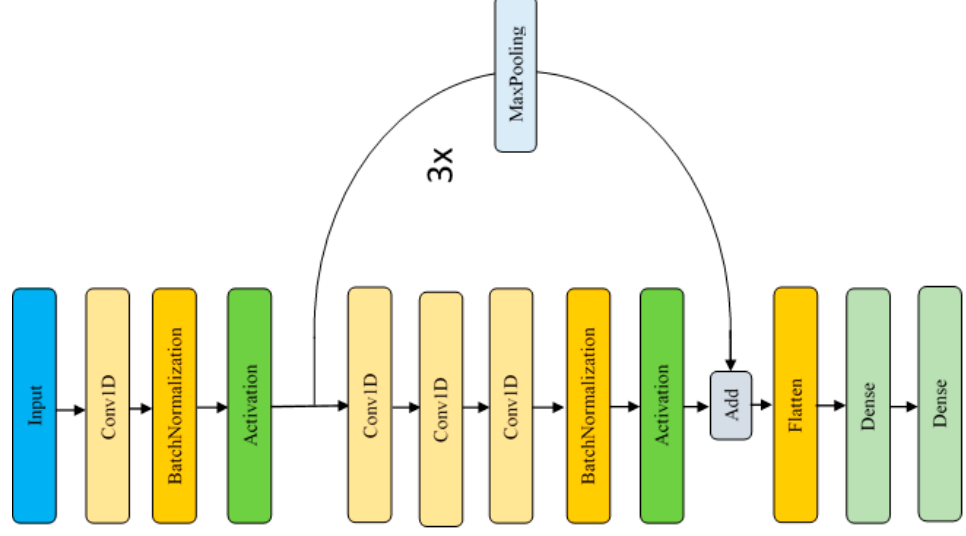
Figure 1. The proposed algorithm using 28 layers of residual depthwise separable convolution neural network.